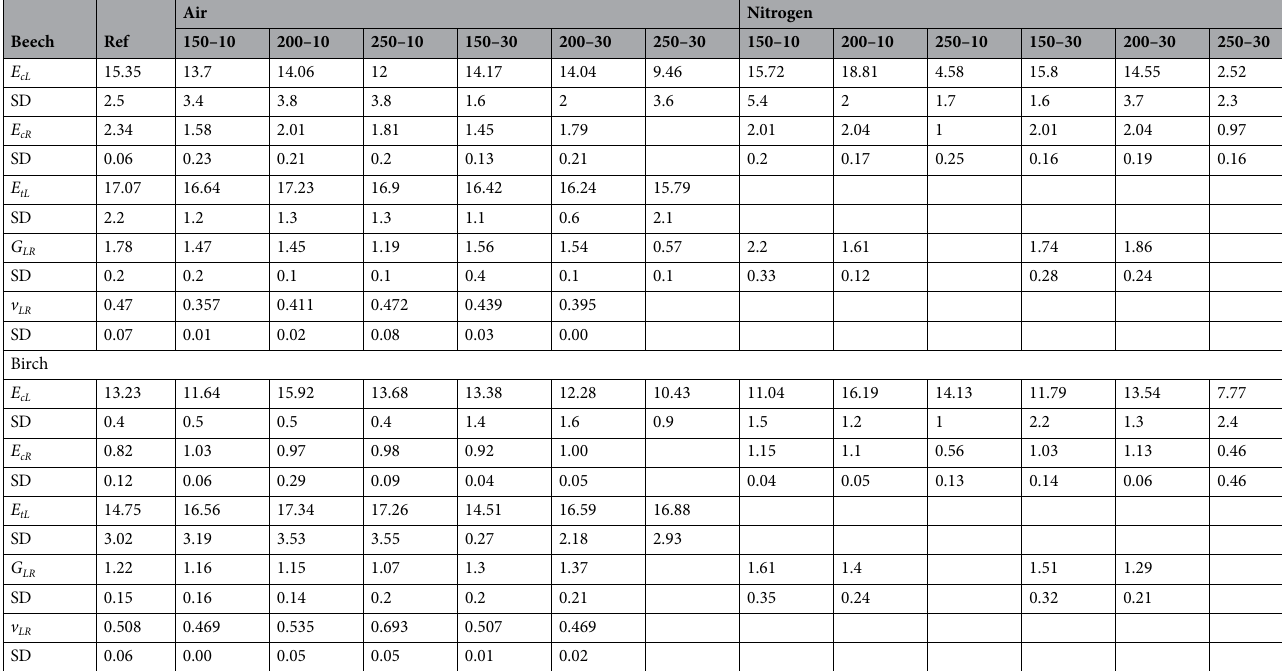
Table 3. Mean values of elastic constants (GPa) and standard deviation % (SD) for heat-treated and untreated beech and birch by quasi-static tests.